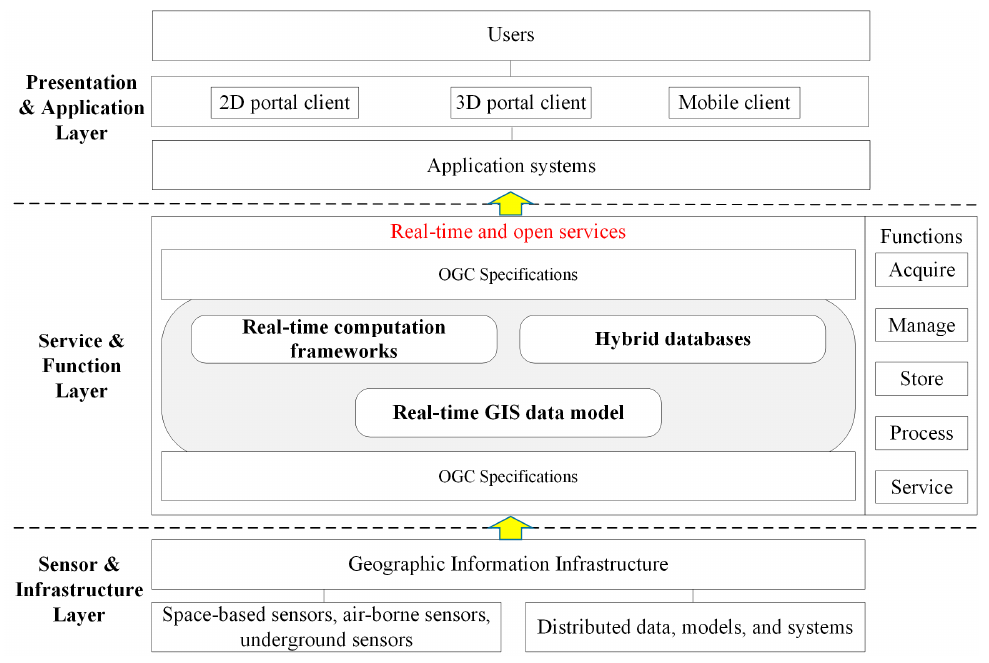
Figure 1. The architecture of the GeoSensor.